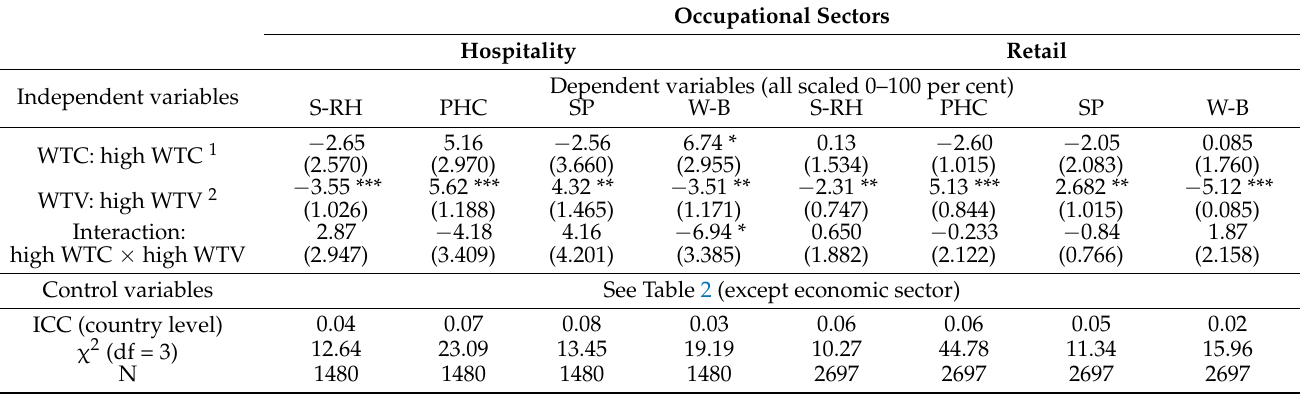
Table A4. Results for occupational sectors, part I (hospitality, retail).